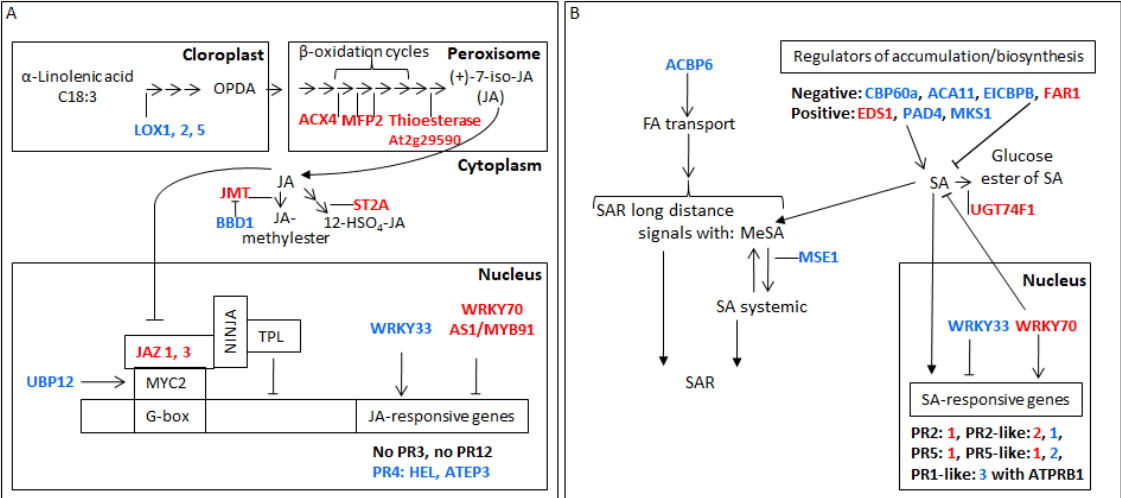
Figure 3: DEGs involved in hormonal pathways during pear/ V. inaequalis nonhost interaction. A: DEGs involved in JA pathway; B: DEGs involved in SA pathway. Genes written in red are induced, genes written in blue are repressed. ACA11: autoinhibited Ca2+-ATPase, calmodulin-activated Ca2+ pumps at the plasma membrane, endoplasmic reticulum (ER), and vacuole. ACBP6: acyl-CoA-binding protein. ACX4: acyl-CoA-oxidase1. AS1/MYB91: Asymmetric leaves 1 transcription factor, CAMTA1: calmodulin-binding transcription activator, CBP60a: calmodulin-binding protein 60a, EDS1: enhanced disease suceptibility 1. FAR1: FAR-red impaired response 1. G-box: cis-element in the promoter. JAZ: jasmonate-zim domain protein, JMT: jasmonic acid carboxyl methyltransferase. LOX: lipoxygenase, MES1: methylesterase